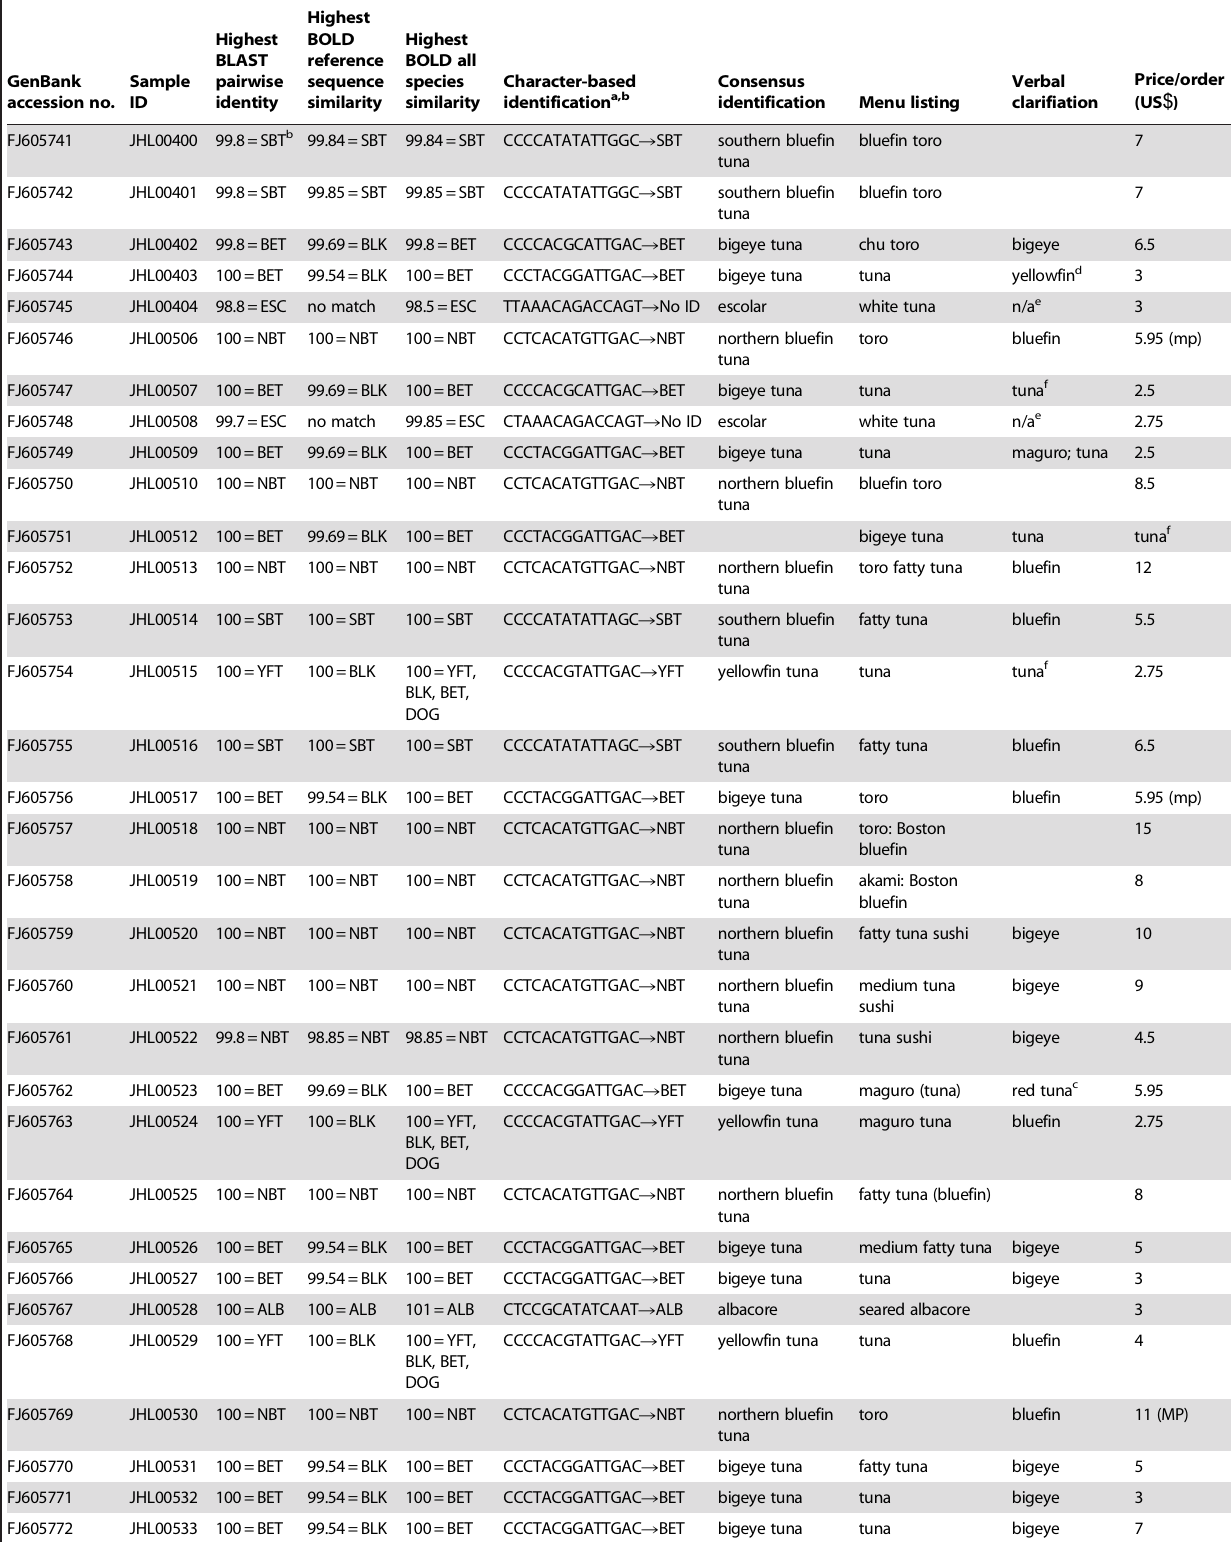
Table 1. Restaurant data and identification of samples using BLAST, BOLD, and characteristic attributes